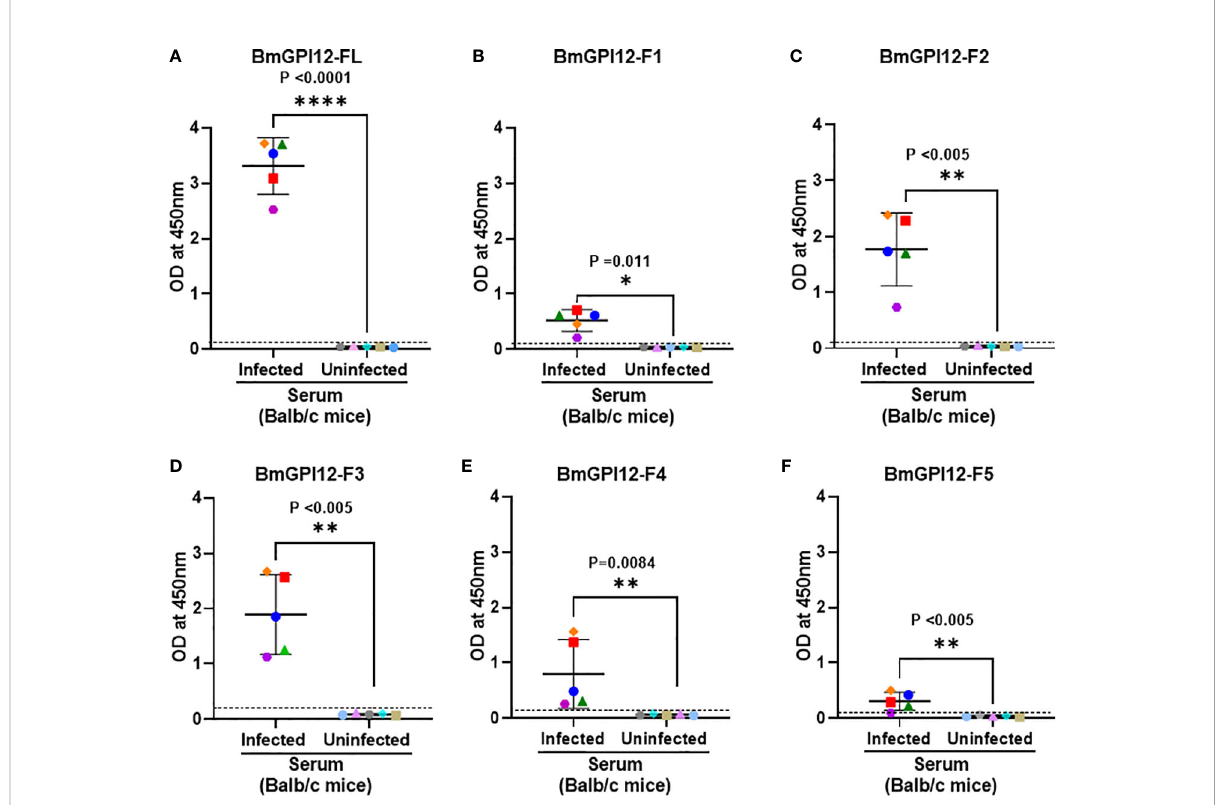
FIGURE 4 Detection of full length BmGPI12 or its sub-fragments by indirect ELISA using uninfected or B microti -infected mouse sera. Heat inactivated sera from B microti -infected or uninfected Balb/c mice were used (1:200 dilution) to detect recombinant BmGPI12-FL or sub-fragments F1, F2, F3, F4 or F5 coated on ELISA plates at 50 ng/well. In all graphs, one color represents the reactivity of each mouse serum sample to different BmGPI12 antigens- FL (A) , F1 (B) , F2 (C) , F3 (D) , F4 (E) and F5 (F) . Each assay was conducted more than once with at least two technical replicates per assay. Error bars denote the standard deviation (SD) calculated using the Graphpad Prism 9.3 software. OD 450 cut-off (dashed line) was determined as the mean + 2 x SD of the OD 450 value of the uninfected samples. ****: statistically signi fi cant (p<0.0001, by two-way ANOVA); **: statistically signi fi cant (p<0.005, by two-way ANOVA); *: statistically signi fi cant (p=0.011, by two-way